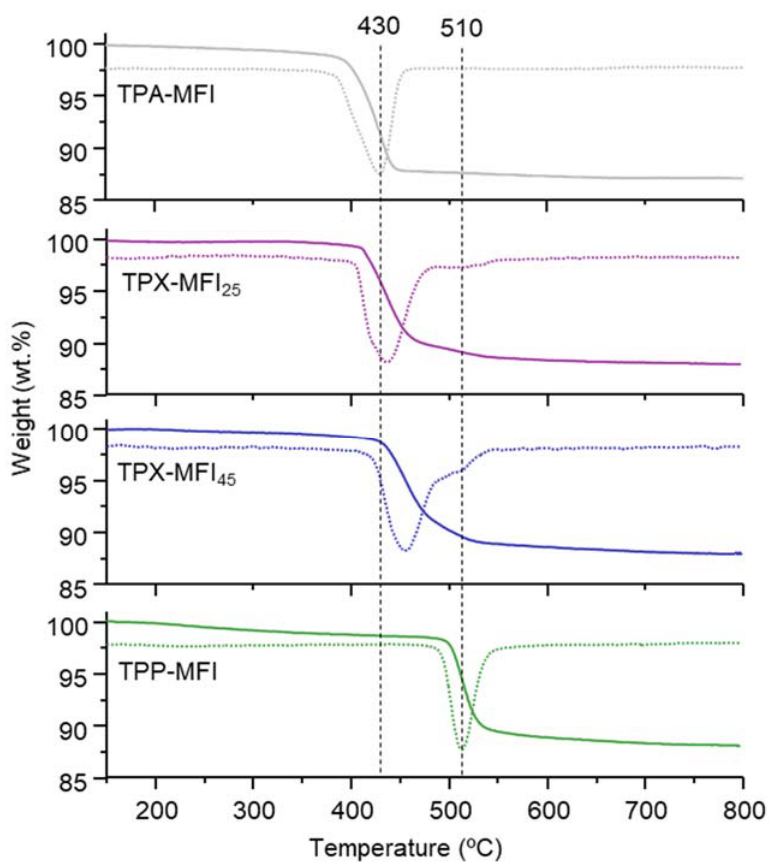
Figure 4. TGA-DTG analyses of silicalite-1 samples synthesized using TPA, TPP, and mixtures of them as OSDAs. Solid lines stand for TGA curves and dashed ones for DTG.